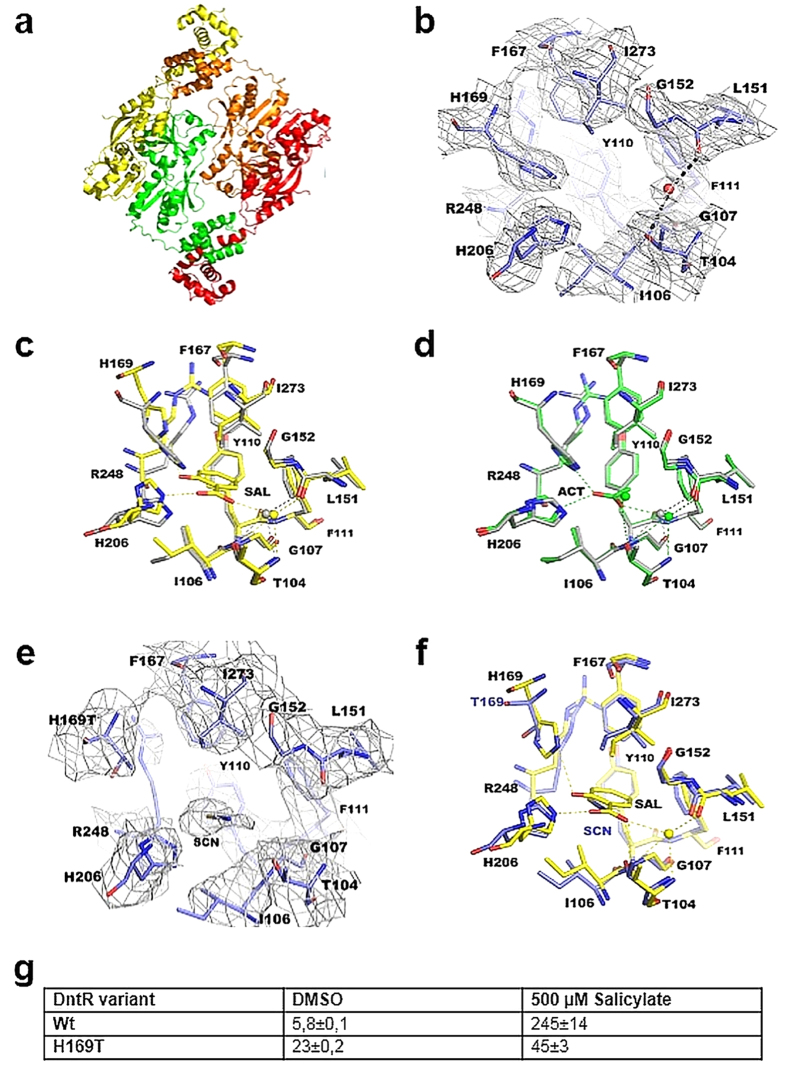
The crystal structures of apo- and H169T-DntR.(a) The crystal structure of apo-DntR with subunits shown in
different colours. The homotetramer adopts a configuration with a compact RD
core. (b) The IBCs in the crystal structure of apo-DntR (stick
representation) contain only ordered water molecules. Carbon atoms in
purple, nitrogen atoms in blue and oxygen atoms in red. Water molecules are
shown as red spheres. 2mFo-DFc,
αcalc ‘omit’ electron
density, contoured at the 1.4 x r.m.s. level, is shown as grey
chicken wire. (c) Superposition of the apo-DntR IBC with that
observed in the crystal structure of open-hinge salicylate-bound DntR
RDs6 (yellow carbon atoms). (d) Superposition of
the IBCs of apo-DntR and acetate-bound DntR5 (green
carbon atoms). (e) The IBCs in the crystal structure of H169T-DntR
(stick representation). Carbon atoms in purple, nitrogen atoms in blue and
oxygen atoms in red. A thiocyanate ion bound in the IBC shown is labelled.
2mFo-DFc, αcalc
‘omit’ electron density, contoured at the
1.0 x r.m.s. level, is shown as grey chicken wire. (f)
Superposition of the IBCs in the crystal structures of H169T-DntR and
open-hinge salicylate-bound holo-DntR RDs6. (g)
The results of flow cytometry measurements show that H169T-DntR autoinduces
transcription albeit at a lower level than fully activated wild-type
DntR.